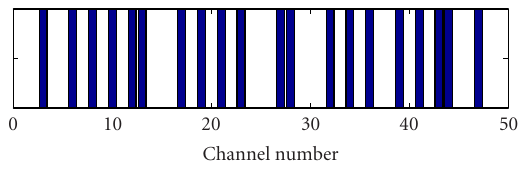
Figure 8: Channel erasure pattern for the 50-channel auditory rep- resentation. Black bars indicate erased channels (40%); white bars stand for intact ones (60%).